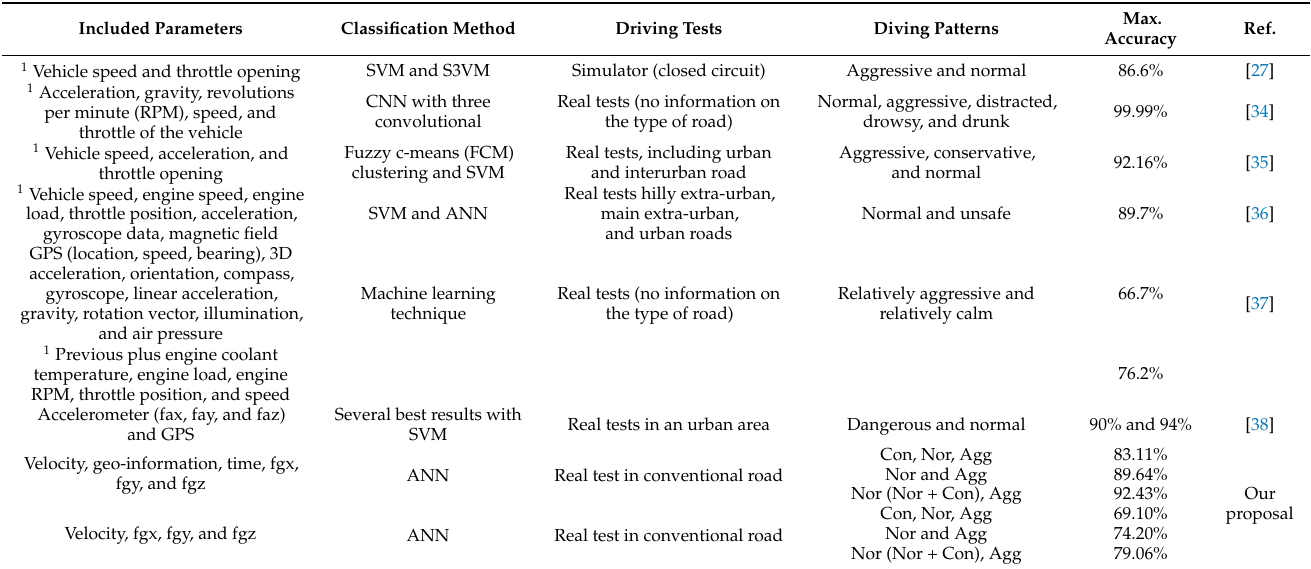
Table 3. Comparison of obtained results with existing